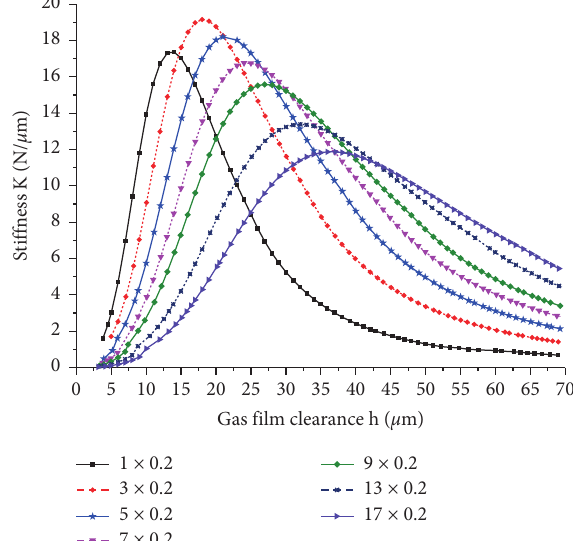
Figure 7: Curve of influence of the number of orifices n on the bearing stiffness.